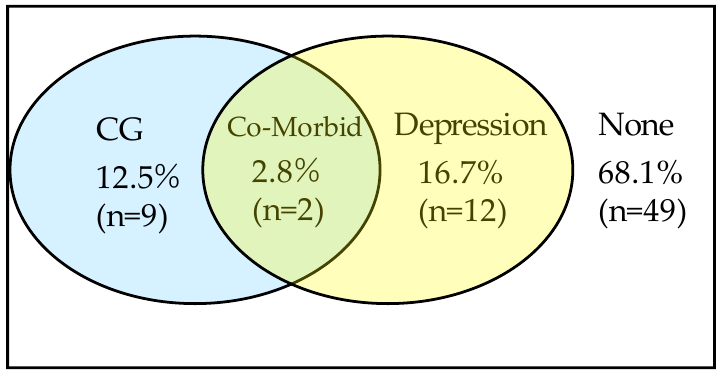
Figure 1. Percentage of complicated grief (CG) and depression in the bereaved family members. 3.3. Correlation between the Total Scores of the PHQ-9, BGQ, GDI, and CES The PHQ-9 score was significantly correlated with the BGQ score (r = 0.481, p = 0.000)